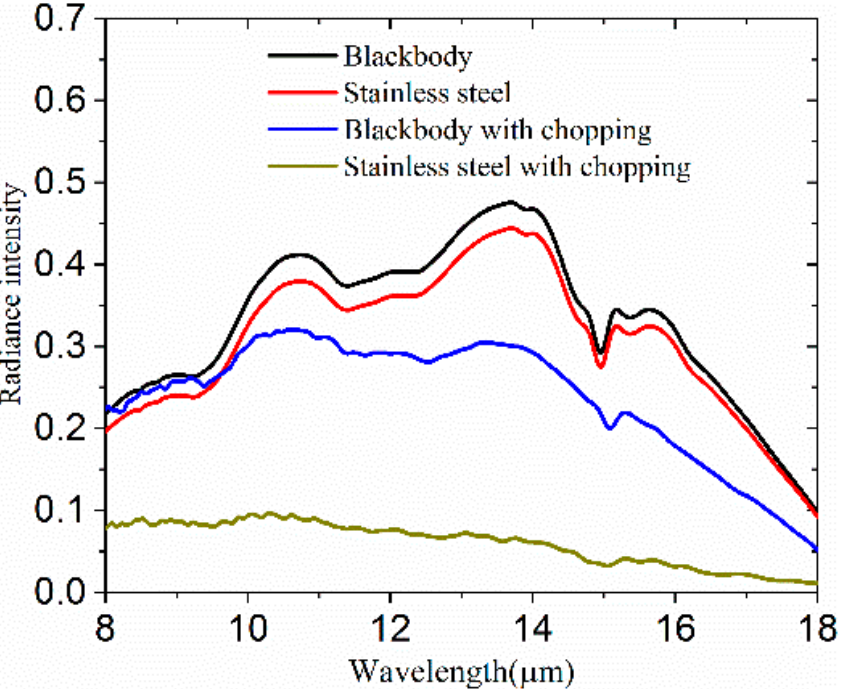
Figure 5. Spectral radiance spectrums of stainless steel and blackbody, with and without modulation, at 323 K.